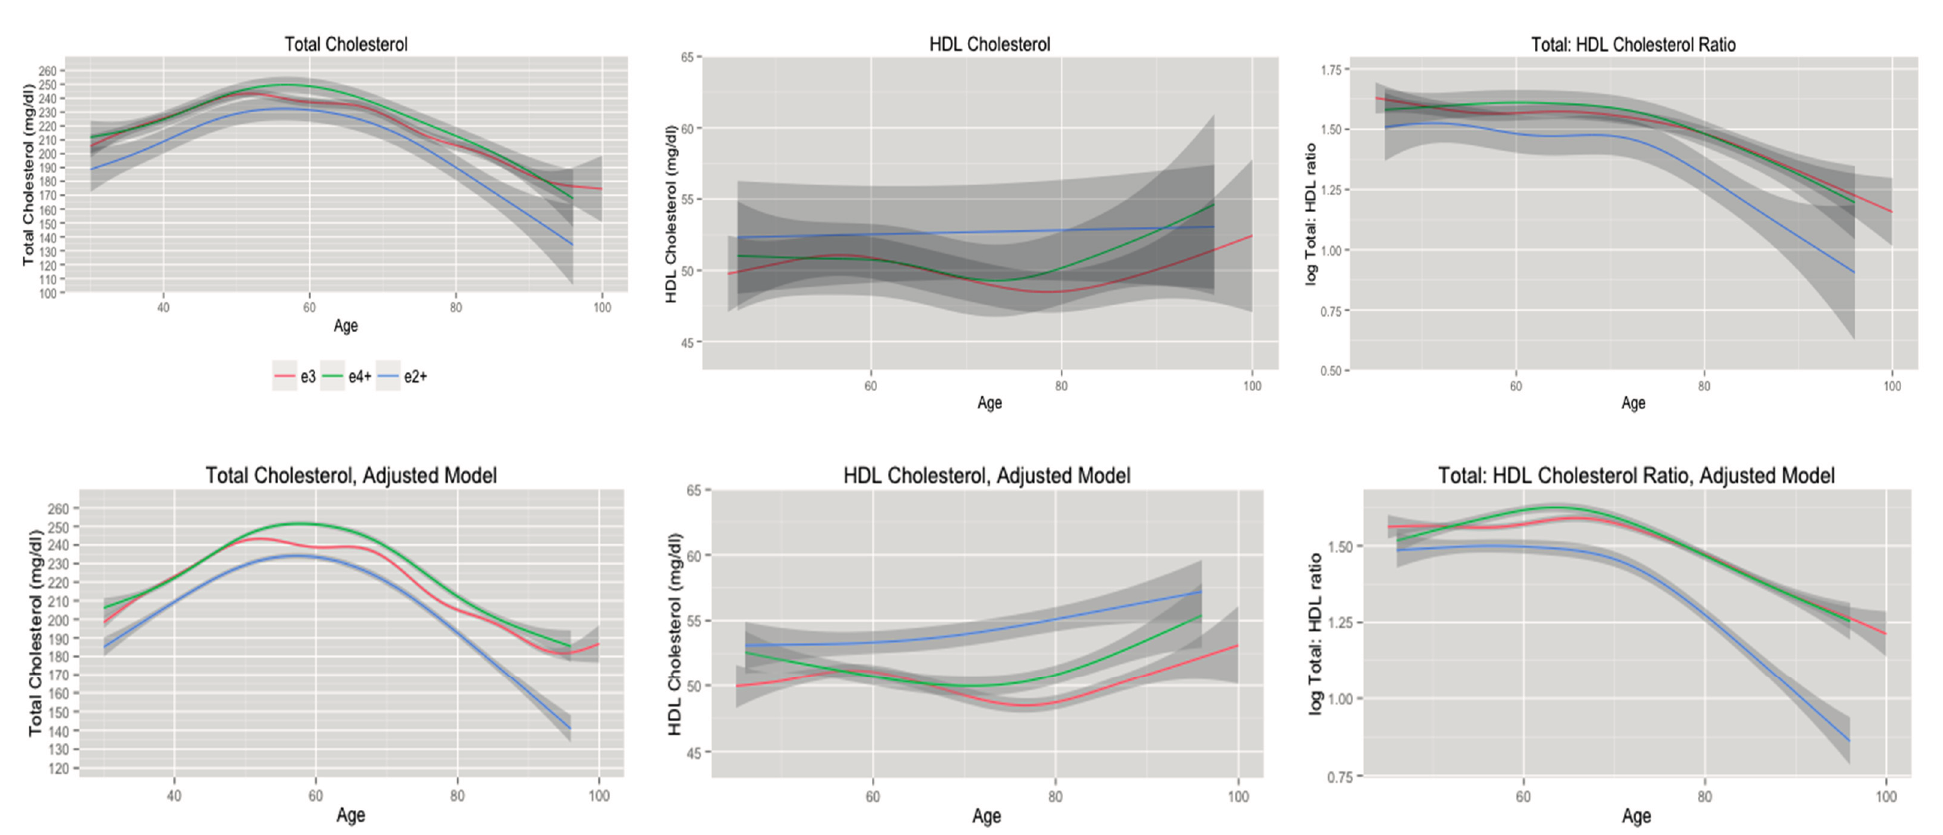
Figure 1. Cholesterol trajectories stratified according to APOE e2+, e3, and e4+ allele